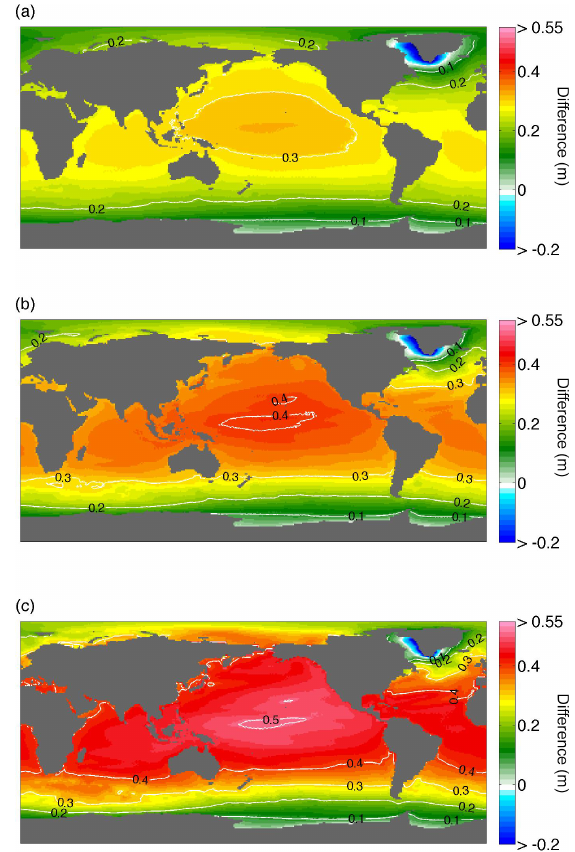
Figure A4. Difference between the (a) 90th, (b) 95th and (c) 97.5th percentile for the asymmetric VW15 simulations (dynamical ice sheet mass loss of the Greenland, East and West Antarctic ice sheet (GIS, EAIS and WAIS) according to De Vries and Van de Wal, 2015) and the asymmetric Ritz simulations (dynamical ice sheet mass loss of EAIS and WAIS according to Ritz et al. (2015), GIS following the symmetric IPCC-AR5 distribution), both combined with regional SLC projections of Slangen et al. (2014) following climate scenario RCP8.5.